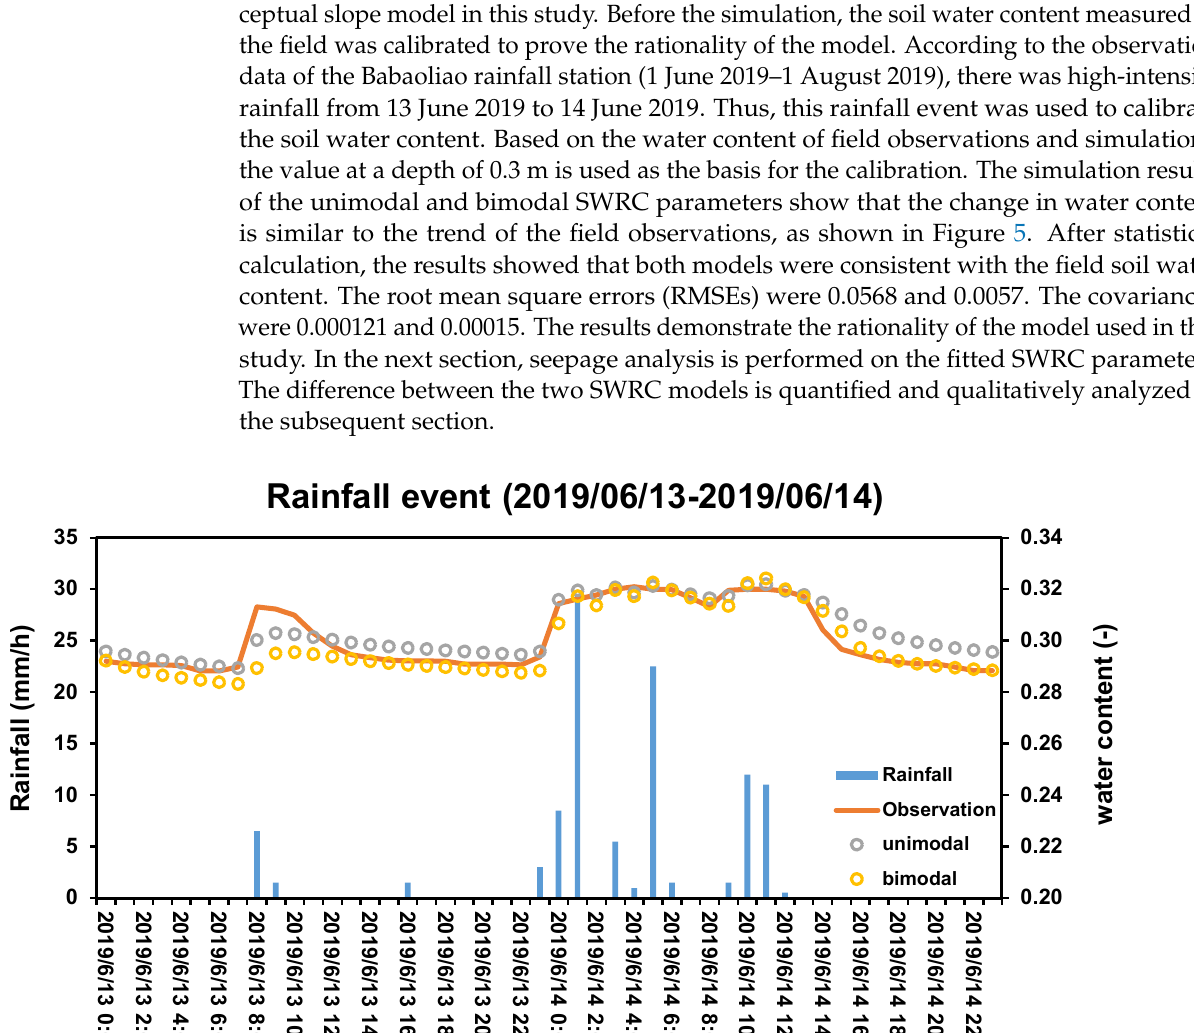
Figure 4. Estimation of unimodal and bimodal hydraulic conductivity function of soil, colluvial, and sandstone.